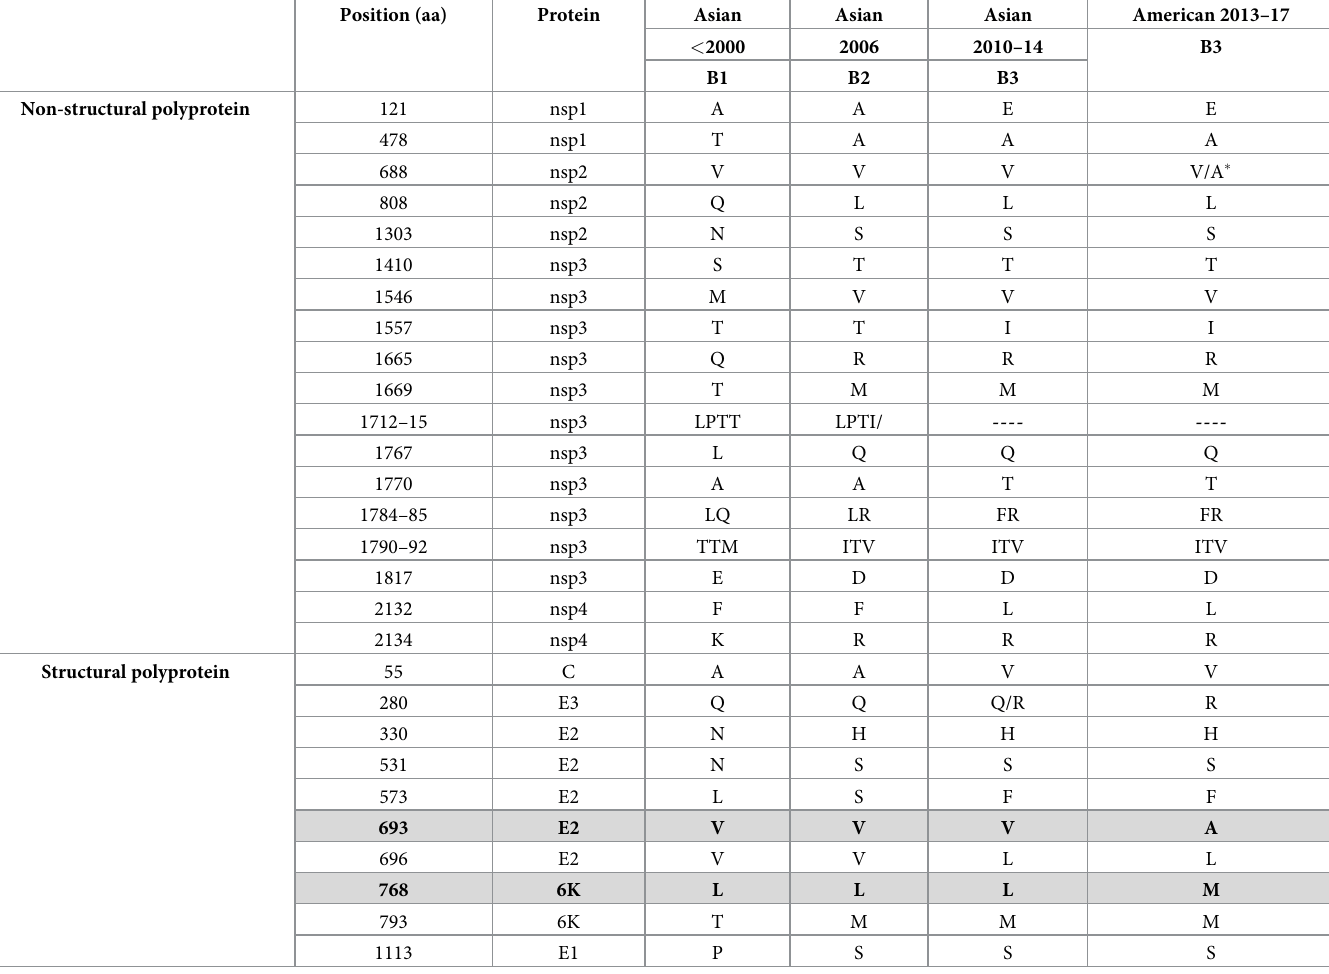
Table 2. Relevant amino acid substitutions identified between Asian genotype clades.